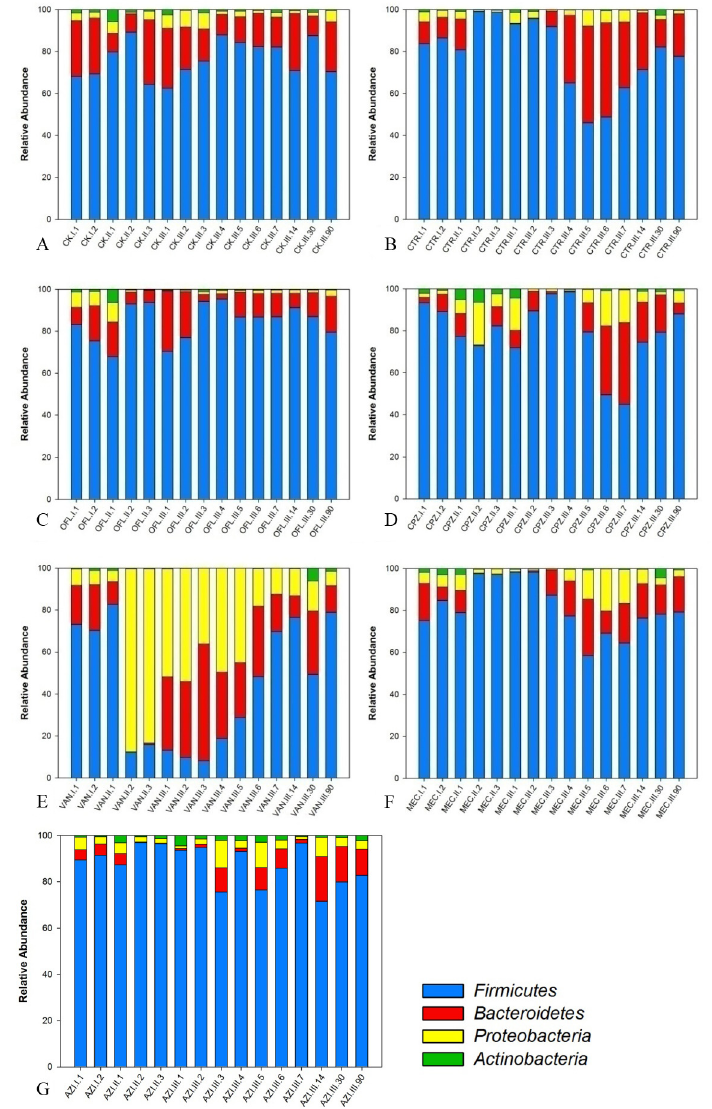
Fig 3. Microbial composition at the phylum level of distribution for different antibiotic groups. A.CK; B. CTR; C. OFL; D. CPZ; E. VAN; F. MEC; G AZI.I is sampling time before antibiotic treatment (I.1, I.2, I.3), II is the sampling during antibiotic administration (II.1, II.2, II.3, II.4), and III is after the antibiotic therapy (III.1, III.2, III.3, III.4, III.5, III.6, III.7, III.14, III.30, III.90). Here, 1, 2, 3, 4 and so on were sampling